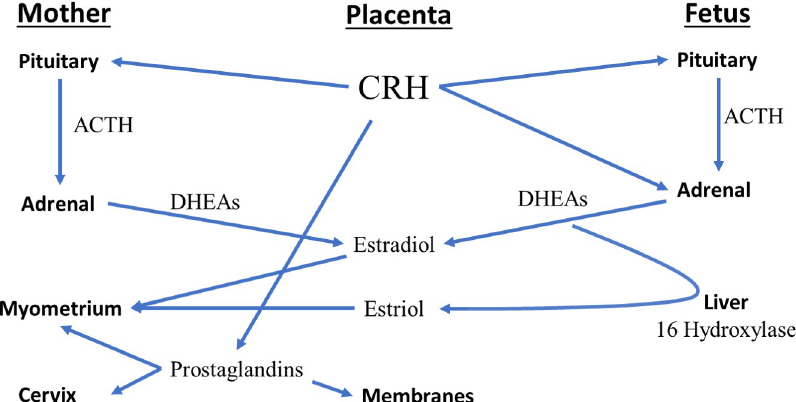
Fig 1. CRH pathways to labor. ACTH = adrenocorticotropic hormone, DHEAs = dehydroepiandrosterone sulfate.